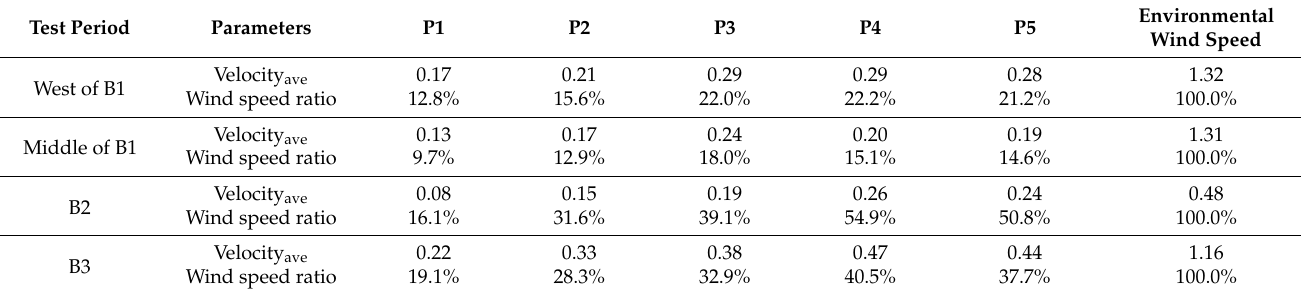
Table 4. Calculation summary of wind speed of three buildings in winter.